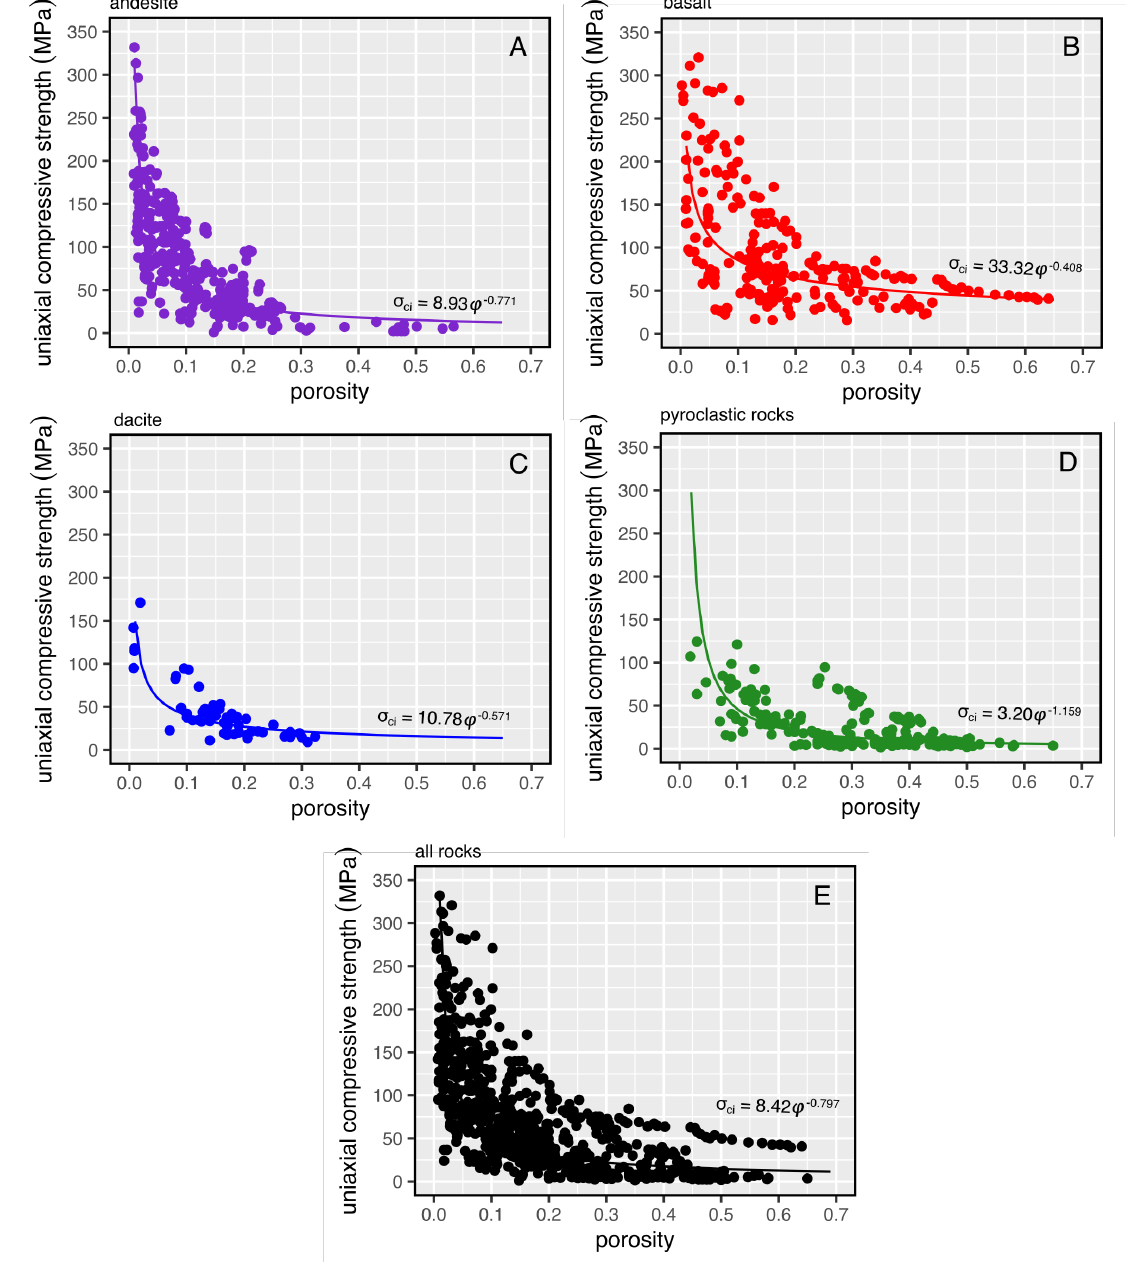
Figure 4: Uniaxial compressive strength as a function of porosity for [A] andesite, [B] basalt, [C] dacite, [D] py- roclastic rocks, and [E] the compiled dataset. The data presented here are for dry samples deformed at room temperature, and each point corresponds to a single test. Best-fit power law fits are provided on each panel (Equation 14 and Table 3). Data from: Behre [1929], Price and Jones [1982], Erguvanlı et al. [1989], Ayday and